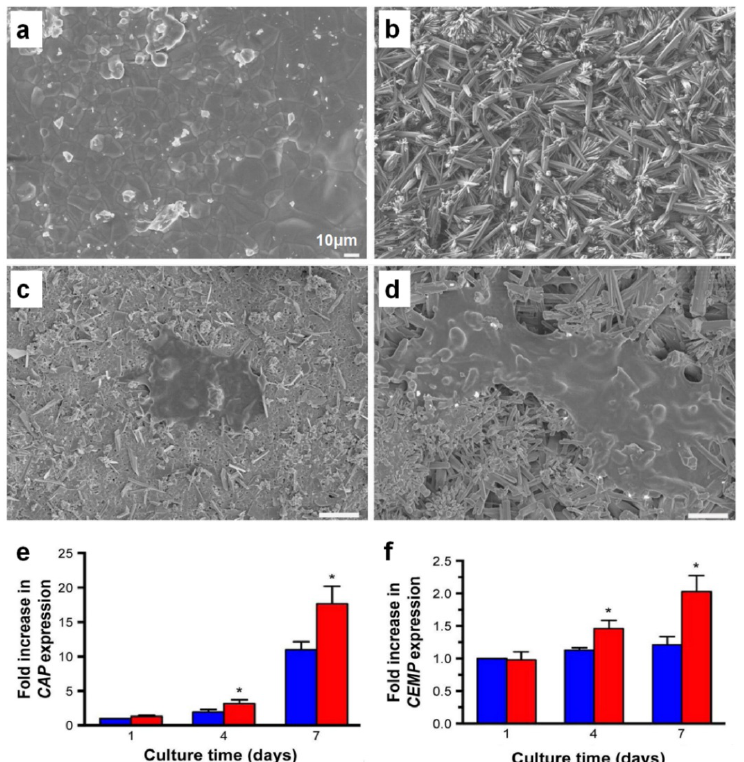
Figure 7. The morphological characterizations of the traditional hydroxyapatite and the nano-/microstructured hydroxyapatite with cementogenic expression levels in vitro. ( a , c ) The traditional hydroxyapatite bioceramic material surfaces were characterized by a scanning electron microscope (SEM) before and after the human PDL stem cell seeding. ( b , d ) The nano-/microstructure characterized hydroxyapatite materials were evaluated using SEM before and after human PDL stem cell seeding. ( e , f ) The cementogenic expression levels were quantitatively assessed with cementum attachment protein (CAP) and cementum protein (CEMP). The fabricated hydroxyapatite surfaces (red columns) showed statistically significant di ff erences from the traditional (blue columns). (* p < 0.05). Adapted with permission from the reference